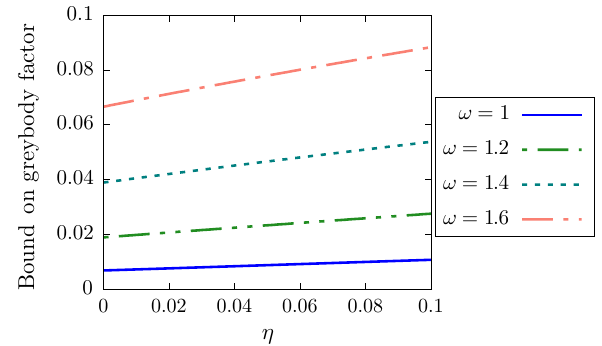
Fig. 9 In the above figure the lower bound on the greybody factor in a radially deformed BH spacetime is plotted with respect to varying η for different fixed ω . We have set the other parameters at l = 2, m = − 1, r s = 1, and a = 0 . 05. This particular case signify one situation of m (cid:5)= 0